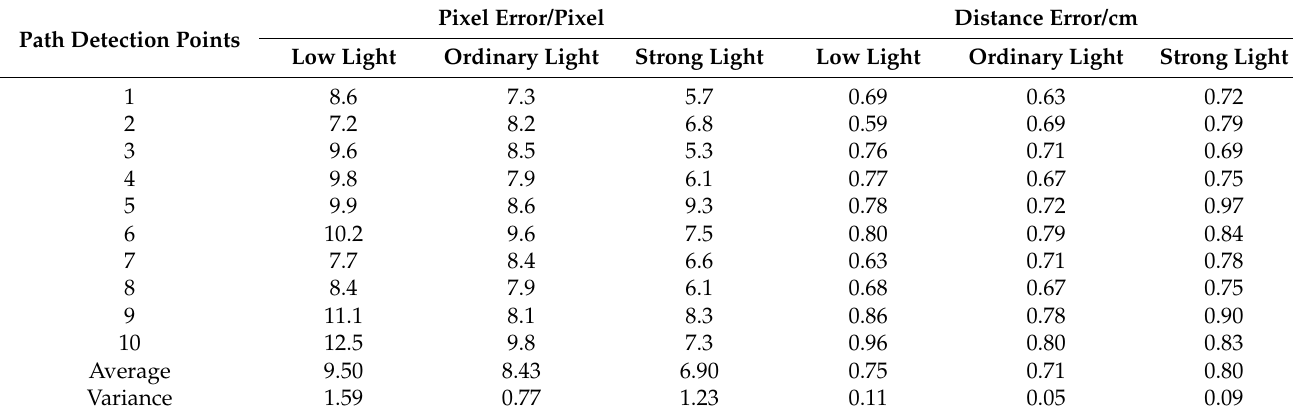
Table 4. The error values of our model.